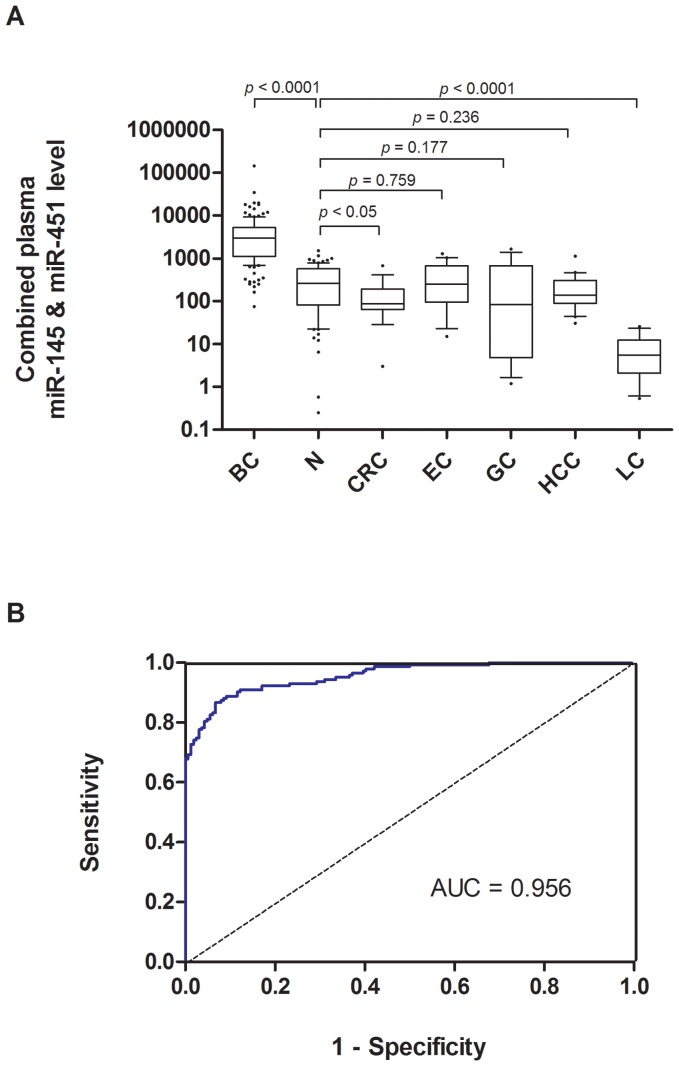
Large-scale validation of combined plasma miR-145 and miR451.(A) Box plot of combined plasma miR-145 and miR-451 levels in patients of breast cancer (BC), healthy normal (N), colorectal cancer (CRC), esophagus cancer (EC), gastric cancer (GC), hepatocellular carcinoma (HCC) and lung cancer (LC). Expression levels of the miRNAs (Log10 scale at Y-axis) are calculated by the equation 2-ΔCt. ΔCt was calculated by subtracting the Ct values of miR-145 from the Ct values of the miR-451. The lines inside the boxes denote the medians. The boxes mark the interval between the 25th and 75th percentiles. The whiskers denote the interval between the 10th and 90th percentiles. Filled circles indicate data points outside the 10th and 90th percentiles. Statistically significant differences were determined using Mann-Whitney tests. (B) ROC analysis using combined plasma miR-451 and miR-145 for discriminating breast cancer from normal subjects and other cancers.